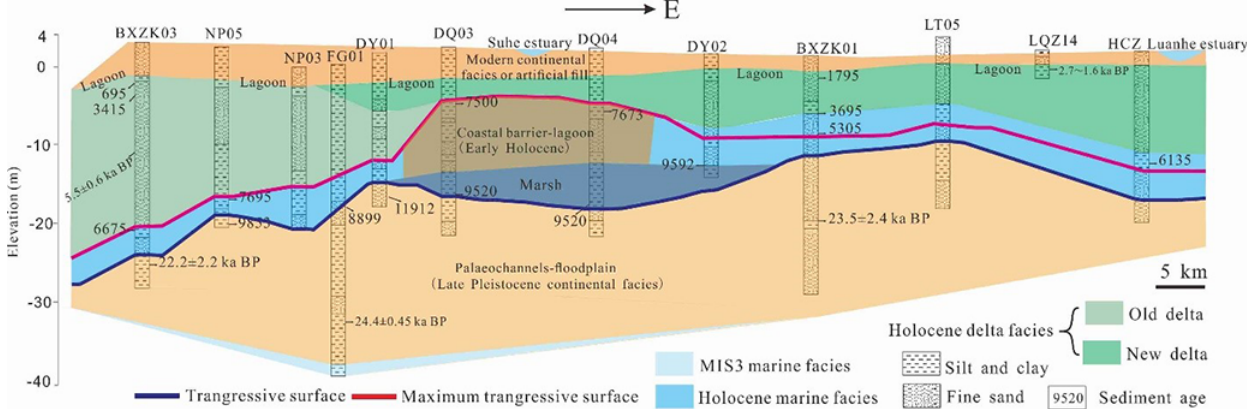
Figure 2. Stratigraphic transect along the present coastline of the Luanhe River delta; modified from He et al. (2020).